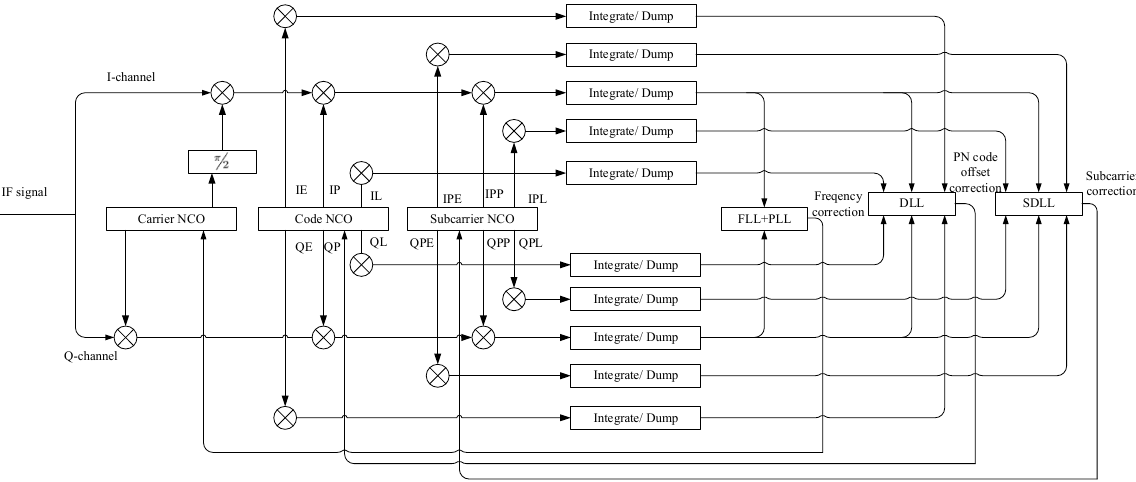
Figure 4. The structure of the tracking loop.